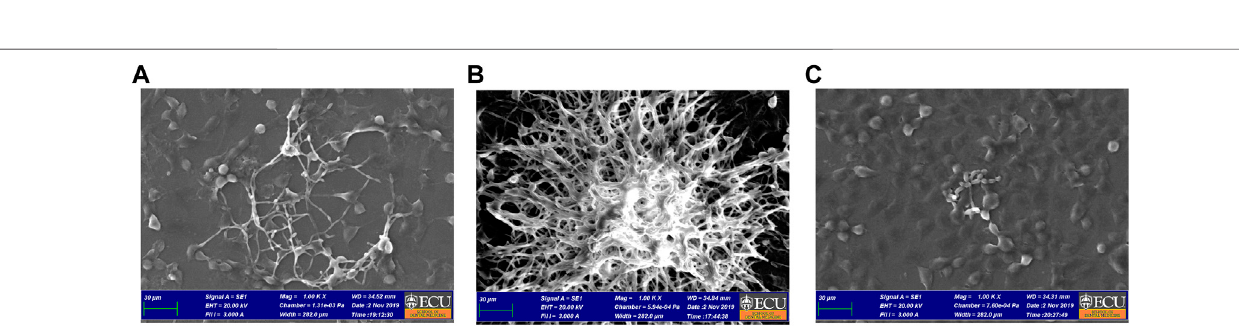
Frontiers in Pharmacology |